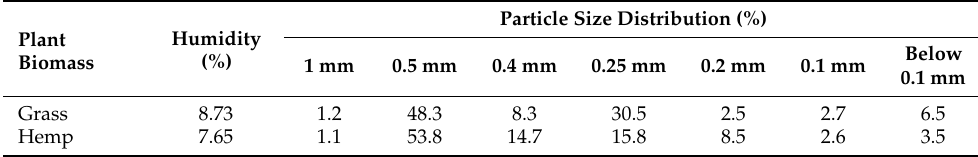
Table 4. Particle size distribution and humidity of fillers from halophyte biomass.